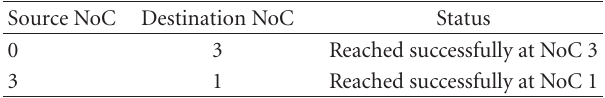
Table 23: The payload successfully reached to its desired destina- tion